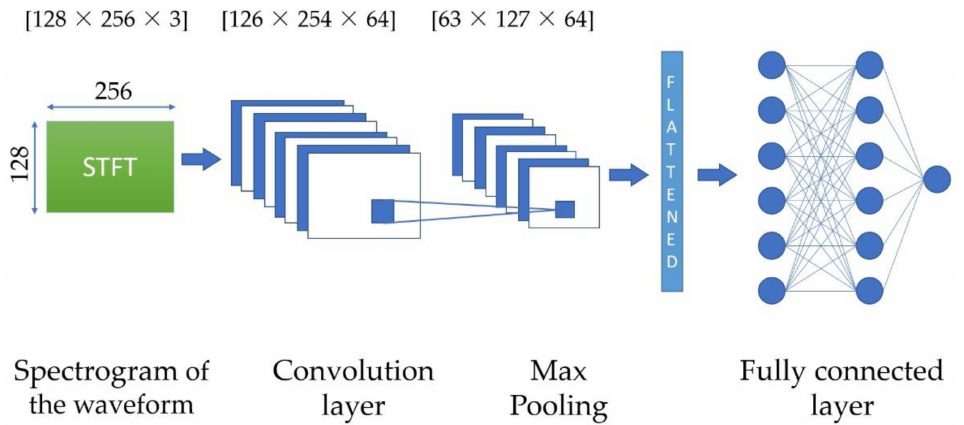
Figure 12. CNN architecture consisting of single convolution, pooling, and fully connected